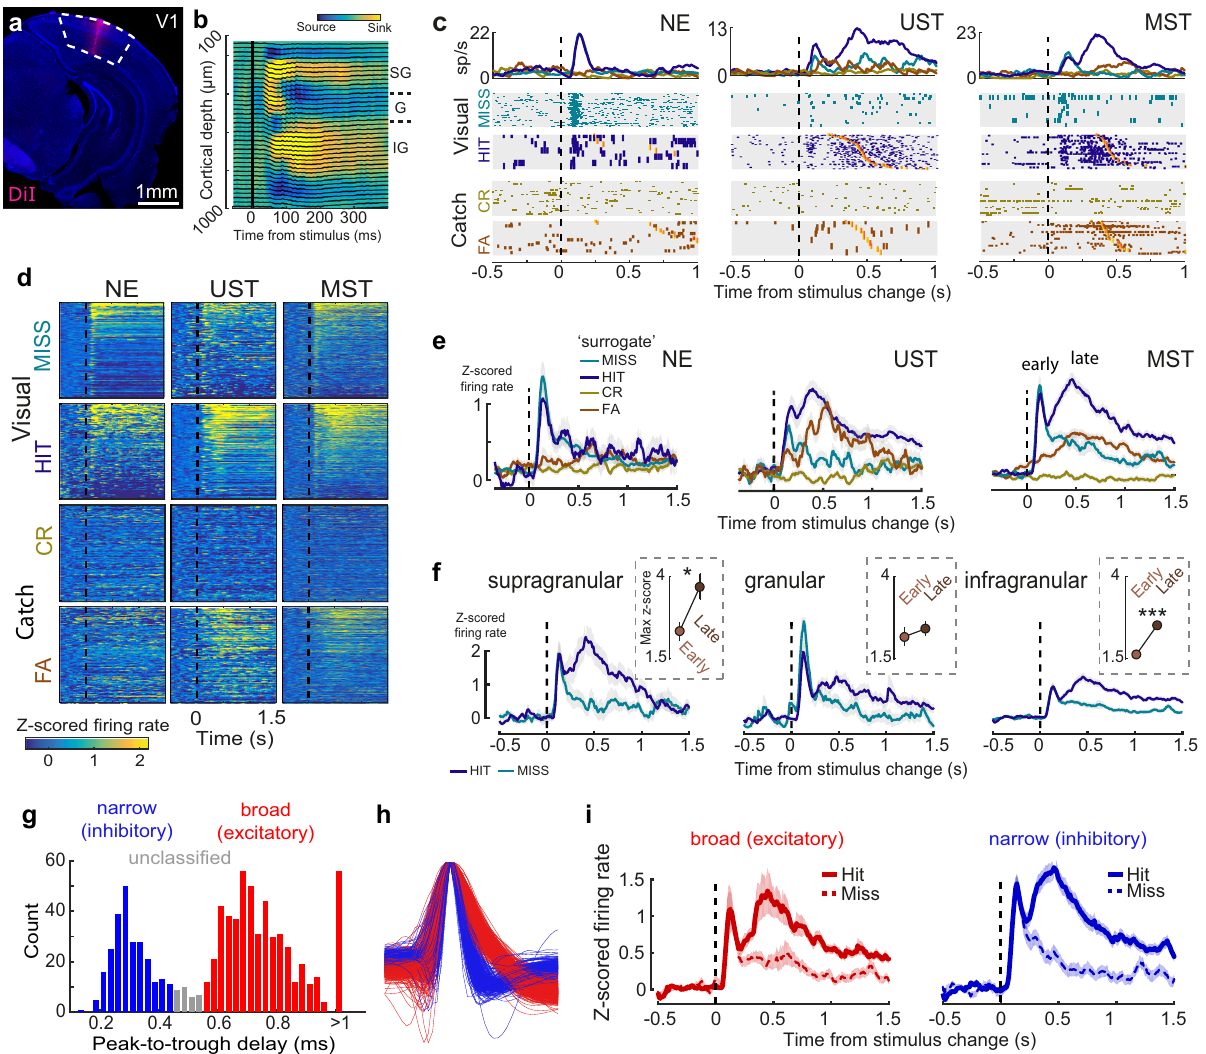
Fig. 2 Multisensory task demands modulate late activity in V1. a Coronal histological section (3.6 mm posterior to bregma) showing silicon probe tract after recording in V1. b Representative example of current source density (CSD) map and LFP traces for checkerboard stimulation. SG = supragranular, G = granular, IG = infragranular. (CSD analysis was repeated with similar results for all 28 mice to determine the depth of probe insertion). c Raster plots (bottom) and fi ring rate (top panel) show stimulus-evoked and report-related activity in three example neurons recorded in V1 (Task A). Raster plots are grouped by trial type (visual or catch) and choice. Within trial type, trials are sorted by post-change orientation and response latency (orange ticks). Note that hits and misses in NE mice are surrogate conditions and are de fi ned post-hoc. CR = correct rejection. FA = visual false alarm. d Heatmaps of trial- averaged z-scored activity of all neurons for the three cohorts for the same conditions as in b . NE neurons: n = 159; UST neurons: n = 128; MST neurons: n = 510. e Averaging z-scored fi ring rate overall neurons for visual and catch trials split by choice reveals biphasic activity in visual hits but not misses, with late activity only present in animals for which visual trials were rewarded (UST and MST). Note the increase in fi ring rates in FA trials for UST and MST mice but not NE mice. The weak early transient activity during FA trials in UST and MST mice during this noisy change detection task might be the result of stochastic variability interpreted as a sensory signal, i.e., falsely perceived changes 96 , although a motor (lick) related signal cannot be excluded. See Supplementary Fig. 3 for an in-depth analysis of the lick-related nature of these responses. f Same as e , but for each laminar zone (neurons from UST and MST mice combined). Inset: maximum z-score during the early (0 – 200 ms) and late (200 – 1000 ms) phase of visual hits (SG: F (1,194) = 4.60, p = 0.03; G: F (1,171) = 0.00, p = 1.00; IG: F (1,1284) = 23.32, p < 0.001, ANOVA). g Histogram of peak-to-trough delay for all neurons (n = 816 neurons) colored by cell type class: narrow-spiking (peak-to-trough delay <0.45ms; putative inhibitory; blue) and broad-spiking (peak-to-trough delay >0.55 ms; putative excitatory; red). Single units with intermediate peak-to-trough values were unclassi fi ed. The peak-to-trough delay was capped at 1 ms for neurons whose trough extended beyond the sampled window. h Normalized average waveform for all V1 neurons colored by cell type class. i Z-scored activity averaged over all broad-spiking V1 neurons (left, n = 421 neurons) or narrow-spiking neurons (right, n = 202 neurons) across UST and MST mice, split by hit/miss response for maximum visual change trials only. Throughout the fi gure, lines and shading are mean ± SEM. the change detection performance of MST mice (Fig. 5f, h). consistent with the primary role of V1 in visual feature V1 silencing did not affect auditory change detection (Supple- processing 31,48,49 . For threshold levels of orientation change (Fig. 5g), the detection of visual change was fully suppressed, mentary Fig. 6b). Moreover, photoillumination of control area S1 indicating that early inactivation of V1 is suf fi cient to impair did not affect visual or auditory performance (Supplementary visual change detection. Interestingly, late silencing only affected Fig. 7). NATURE COMMUNICATIONS| (2022) 13:2864